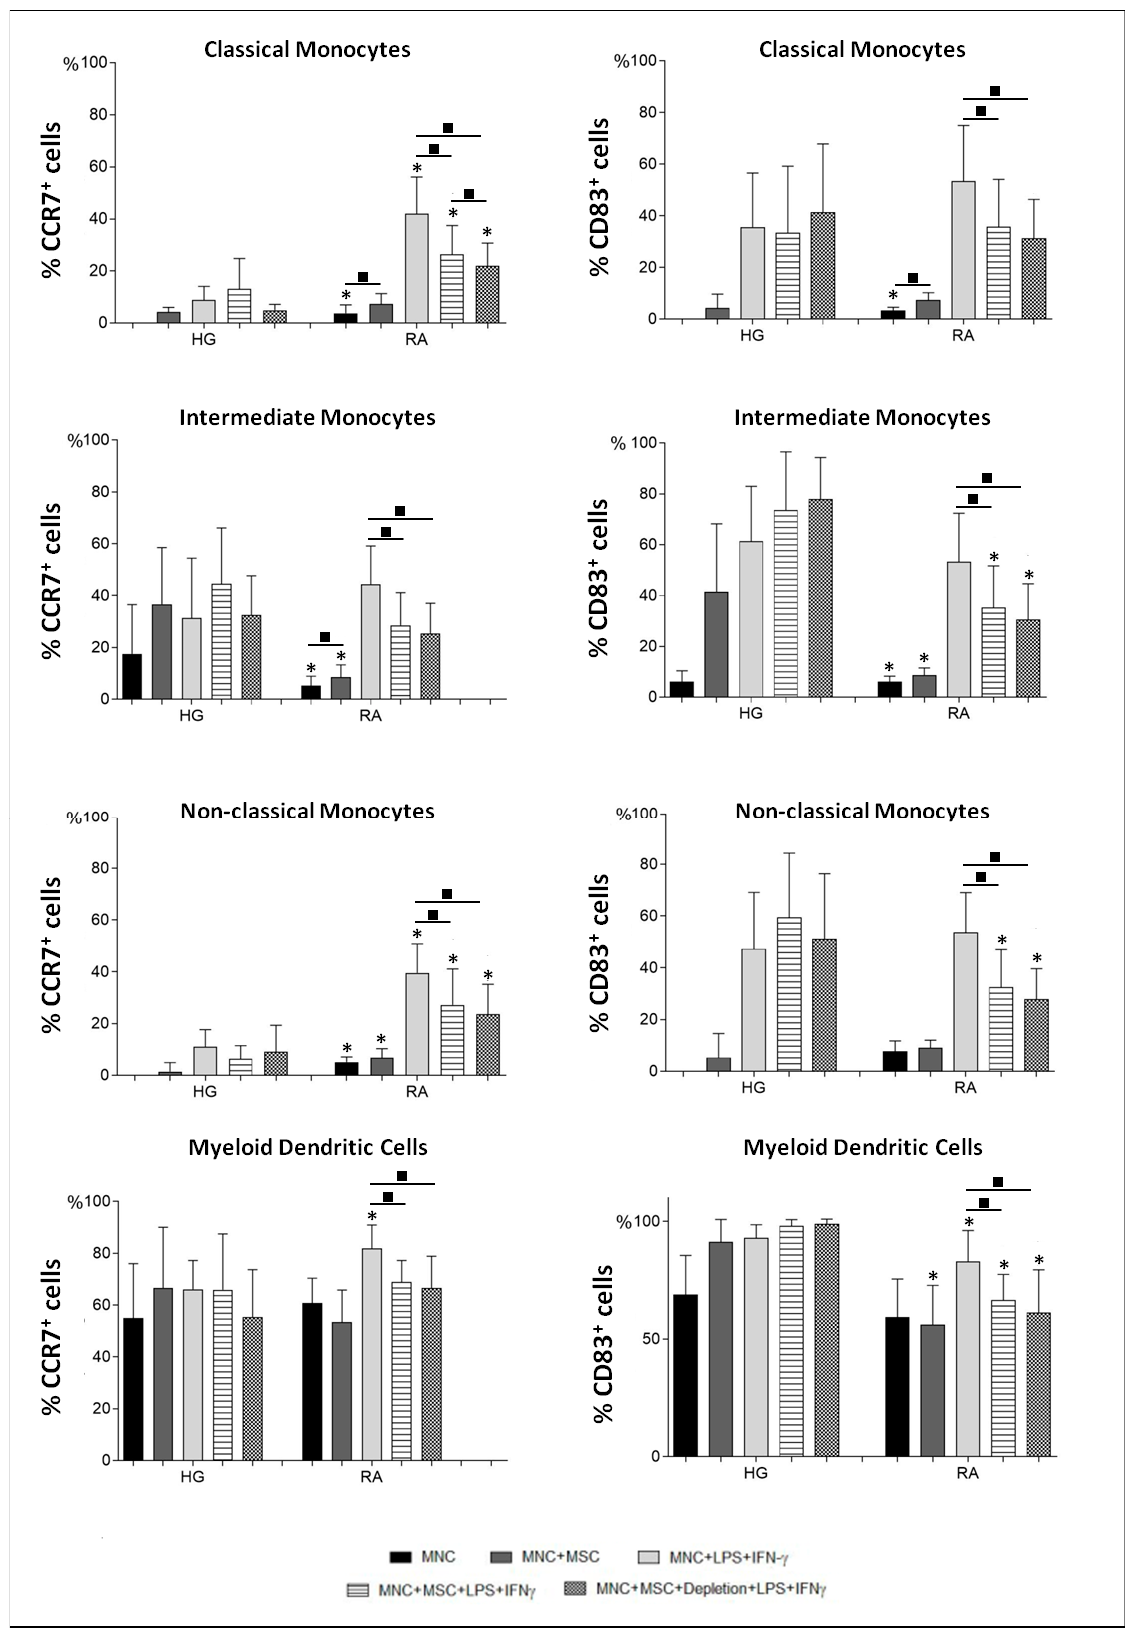
Figure 7. Influence of BM-MSCs over the protein levels of CCR7 and CD83 by monocyte subsets and mDCs from RA patients and healthy individuals. Percentage (mean ± standard deviation) of CCR7 + and CD83 + cells, among monocyte subpopulations (classical, intermediate and non-classical)